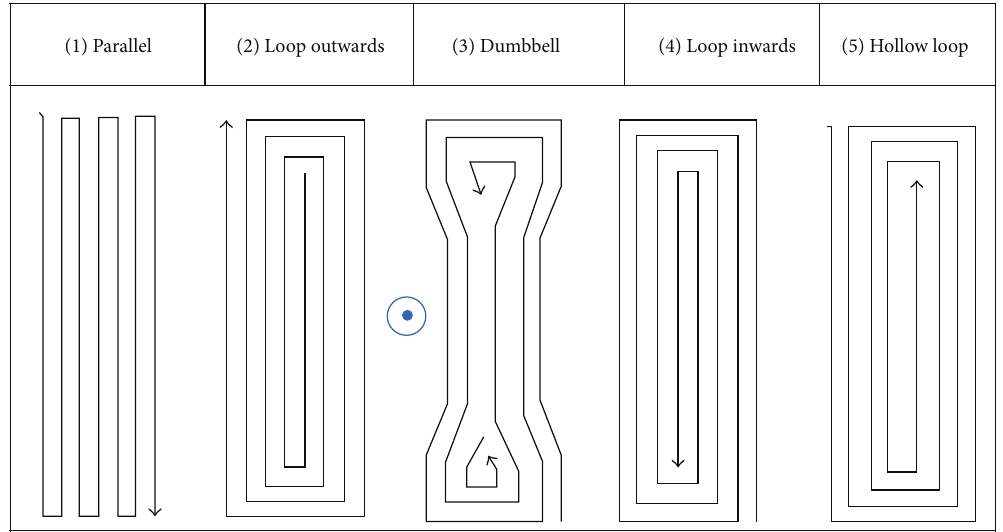
Figure 3: Trajectory strategies for tensile specimens (blue = build direction).